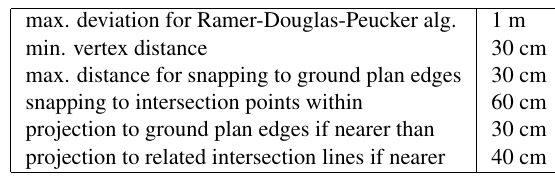
Table 1: Threshold values for polygon simplification and